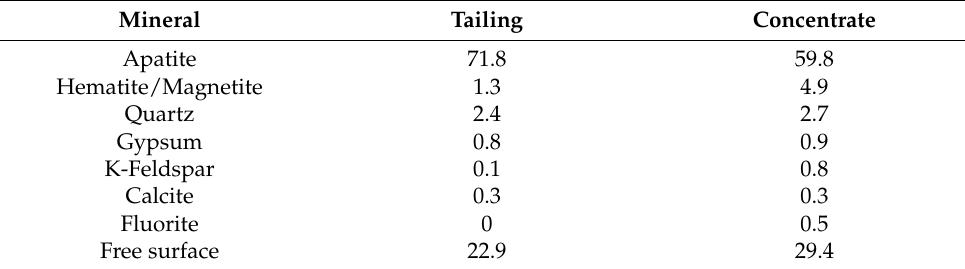
Table 4. Mineral liberation of monazite in flotation tailings and concentrates.